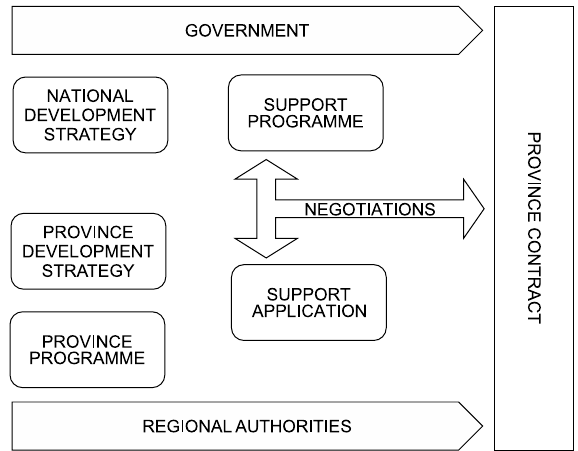
Fig. 1. Model of the first edition of the province contract in Poland. Source: own study on the basis of Kawałko